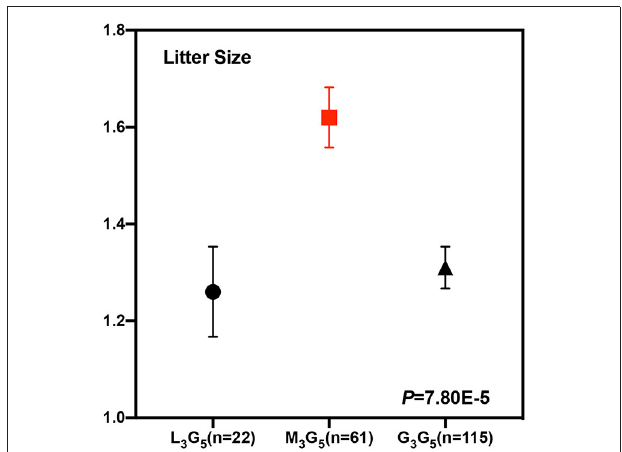
FIGURE 4 | Least squares mean and standard error for litter size of the different combination genotypes of CNV3 and CNV5 within the Fec B gene in